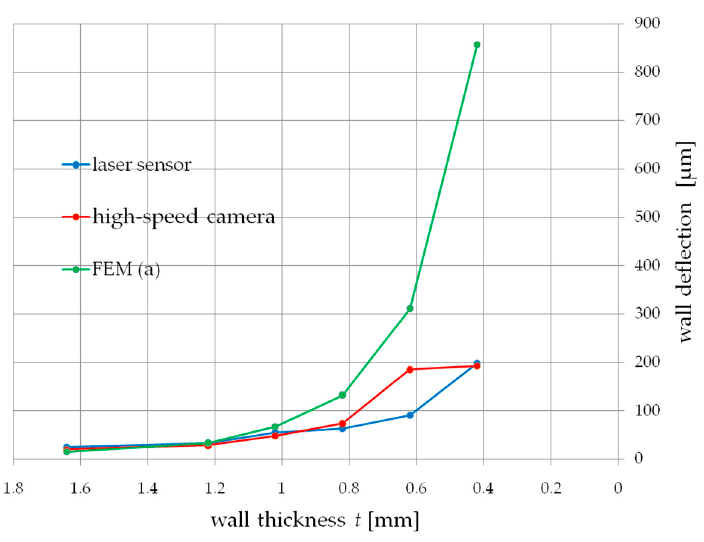
Figure 10. Finite element analysis—wall deflection under the influence of a constant force, test a.